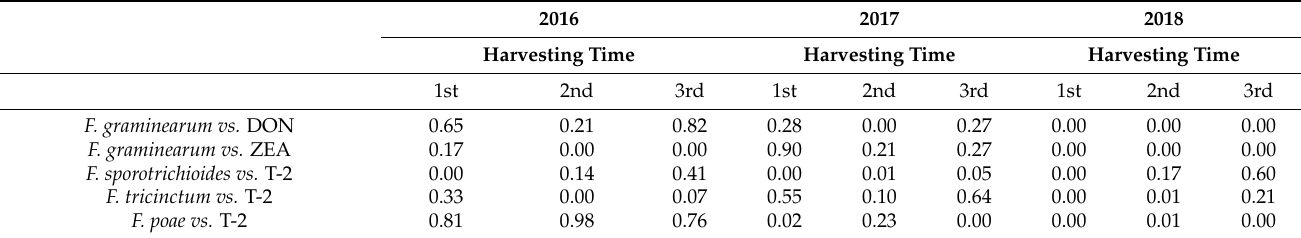
Table 3. The correlation coefficients ( r ) between Fusarium species and mycotoxins in spring wheat grain.